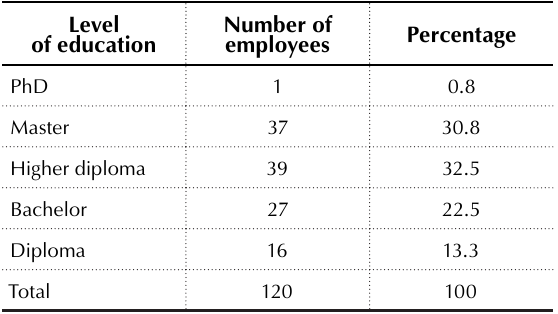
Table 4. Frequency distribution of the study sample according to their educational